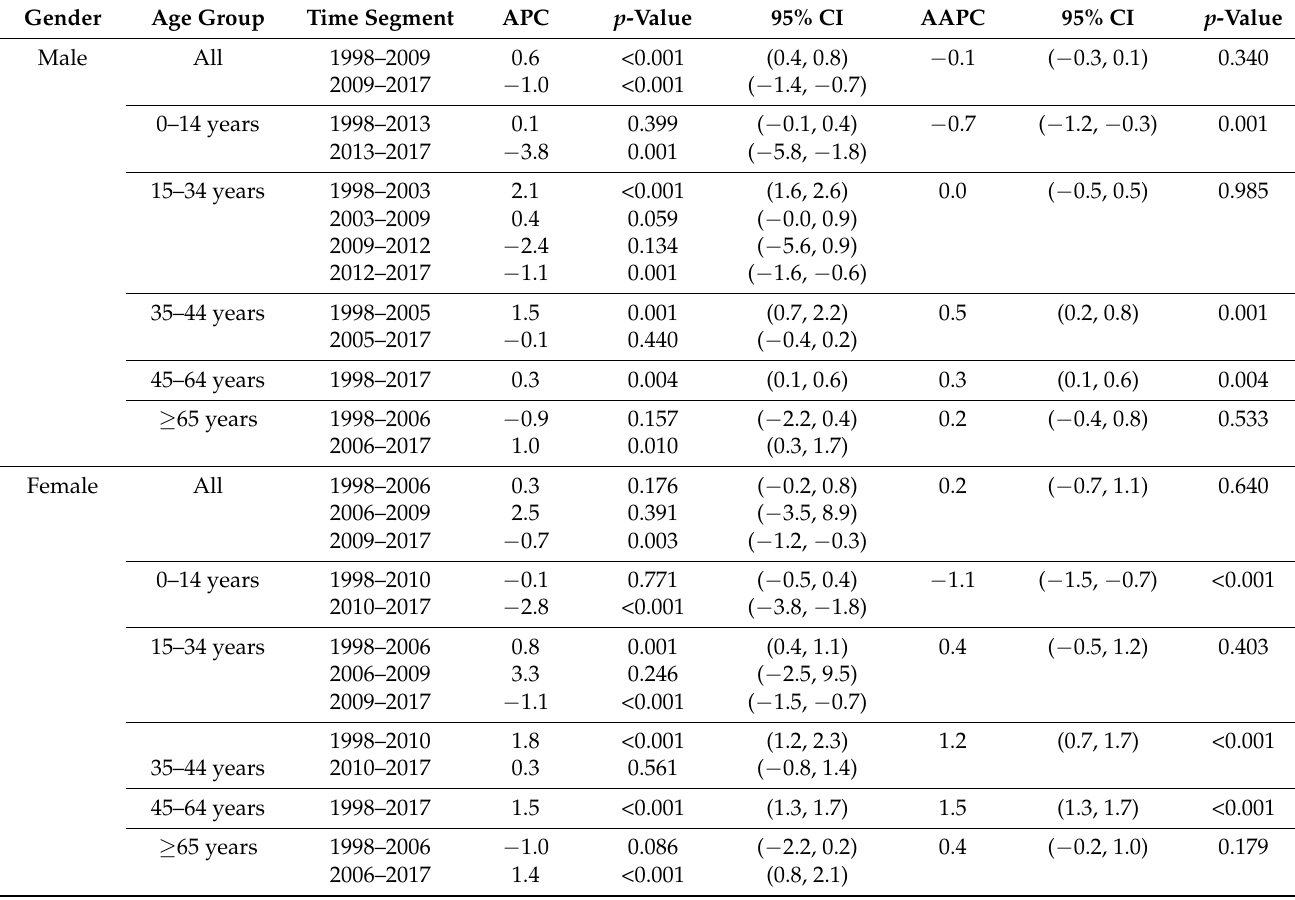
Table 1. Trend segments and annual percent change (APC) in age-standardized hospital admission rates for acute appen- dicitis in Spain, obtained using joinpoint regression models, by sex and age group, 1998 to